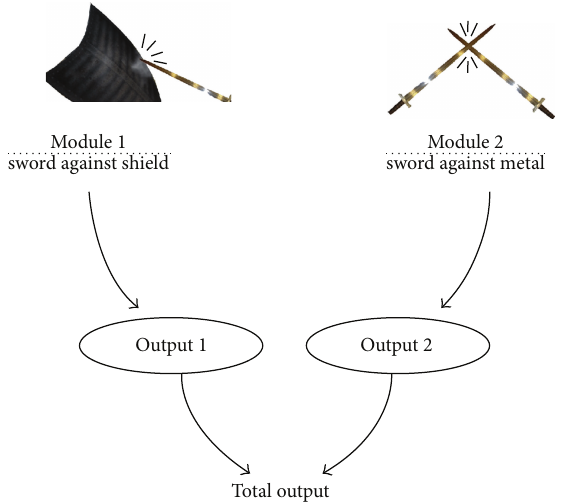
Figure 7: Illustration of the design of the collision sounds of the sword, combining the two